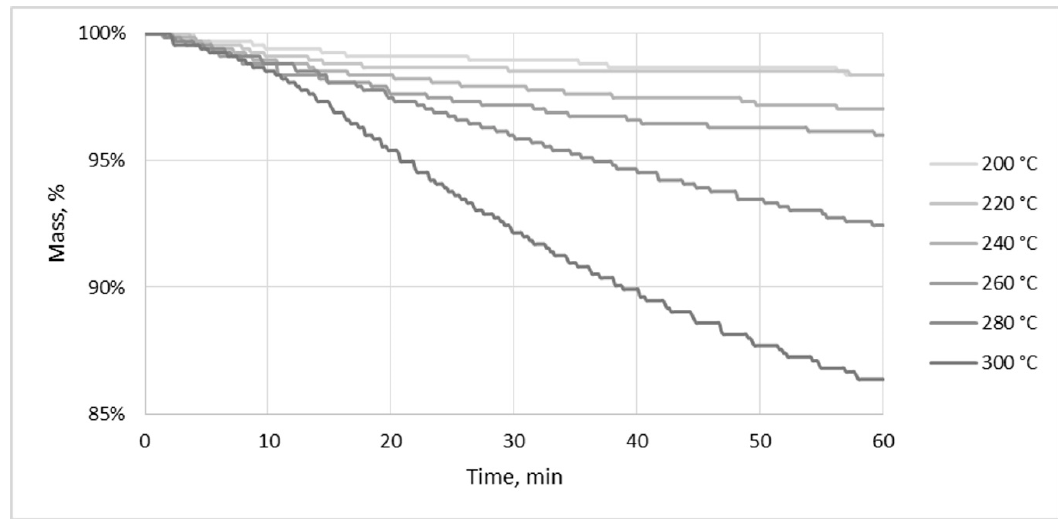
Figure 11. TGA of sewage sludge at torrefaction temperatures.